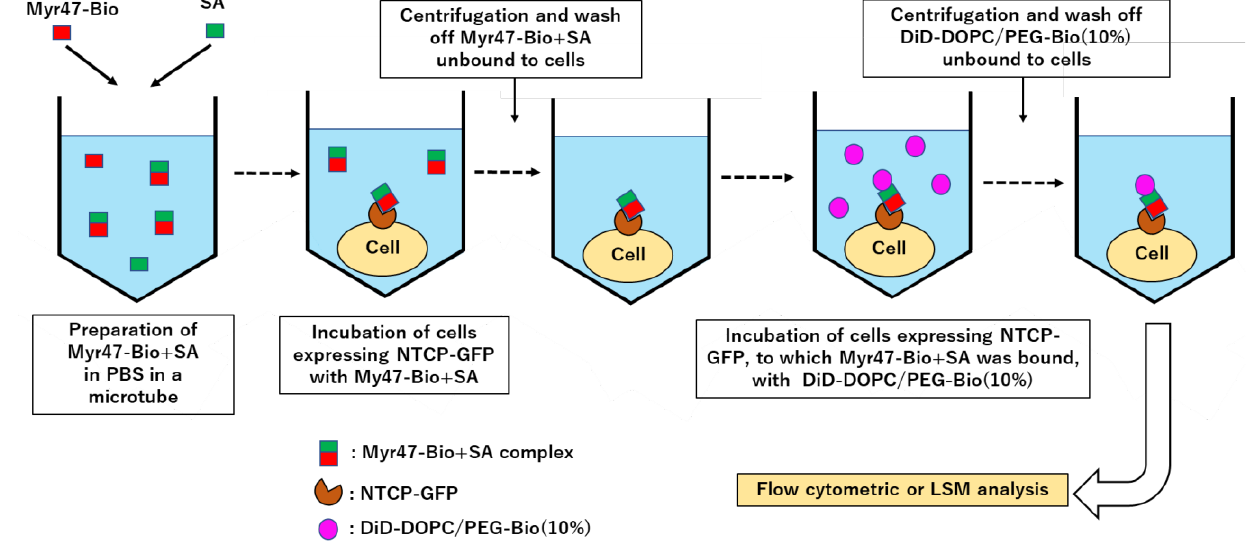
Figure 3. Schema of an experimental procedure to detect liposomal binding to NTCP-GFP expressed on HEK293T cells via Myr47-Bio+SA.